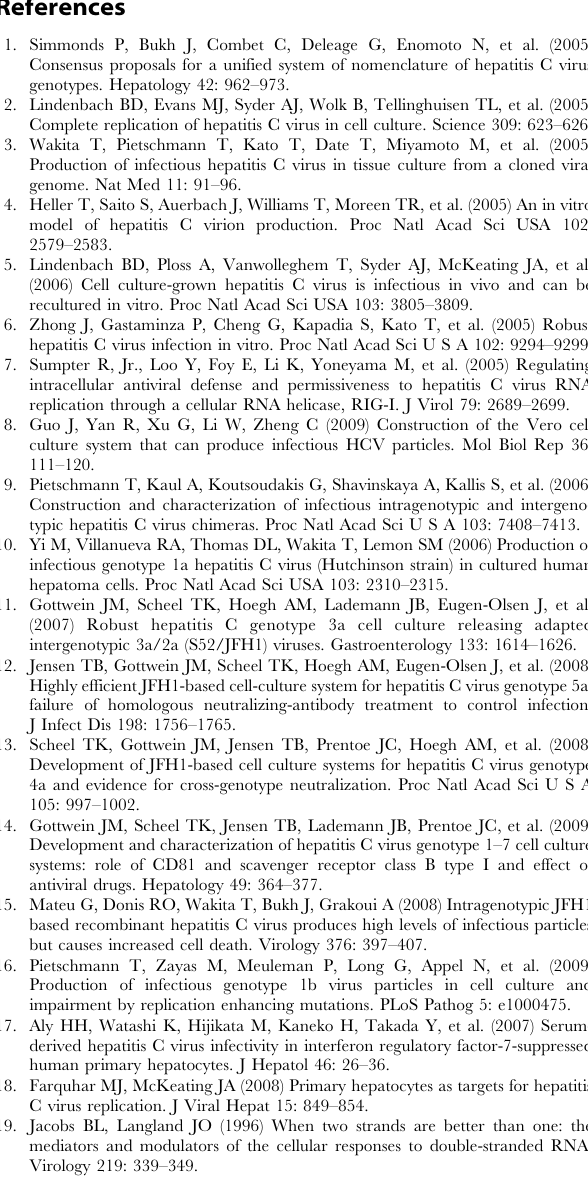
Figure S1 LB-piVe shares sequence homology but not identity with prototype genotype 1b strain. Nucleotide sequence alignment of LB-piVe derived from clones fragments amplified from persistently infected cells. The 3 9 -UTR amplicons derived from each clone were sequenced bidirectionally. The HCV genotype 1b sequence (EU155326.2) is shown on the third line. Nucleotides in the sequences identical to those of the reference are shown in green, similar nucleotides (purines or pyrimidines) are shown in cyan, deletions are shown as dashes, and different nucleotides are shown in white. Numbering of the nucleotides is according to the EU155326.2 HCV genotype 1b sequence. LB-piVe: virus derived from LB-piVe cells; LB: serum-derived parental virus.